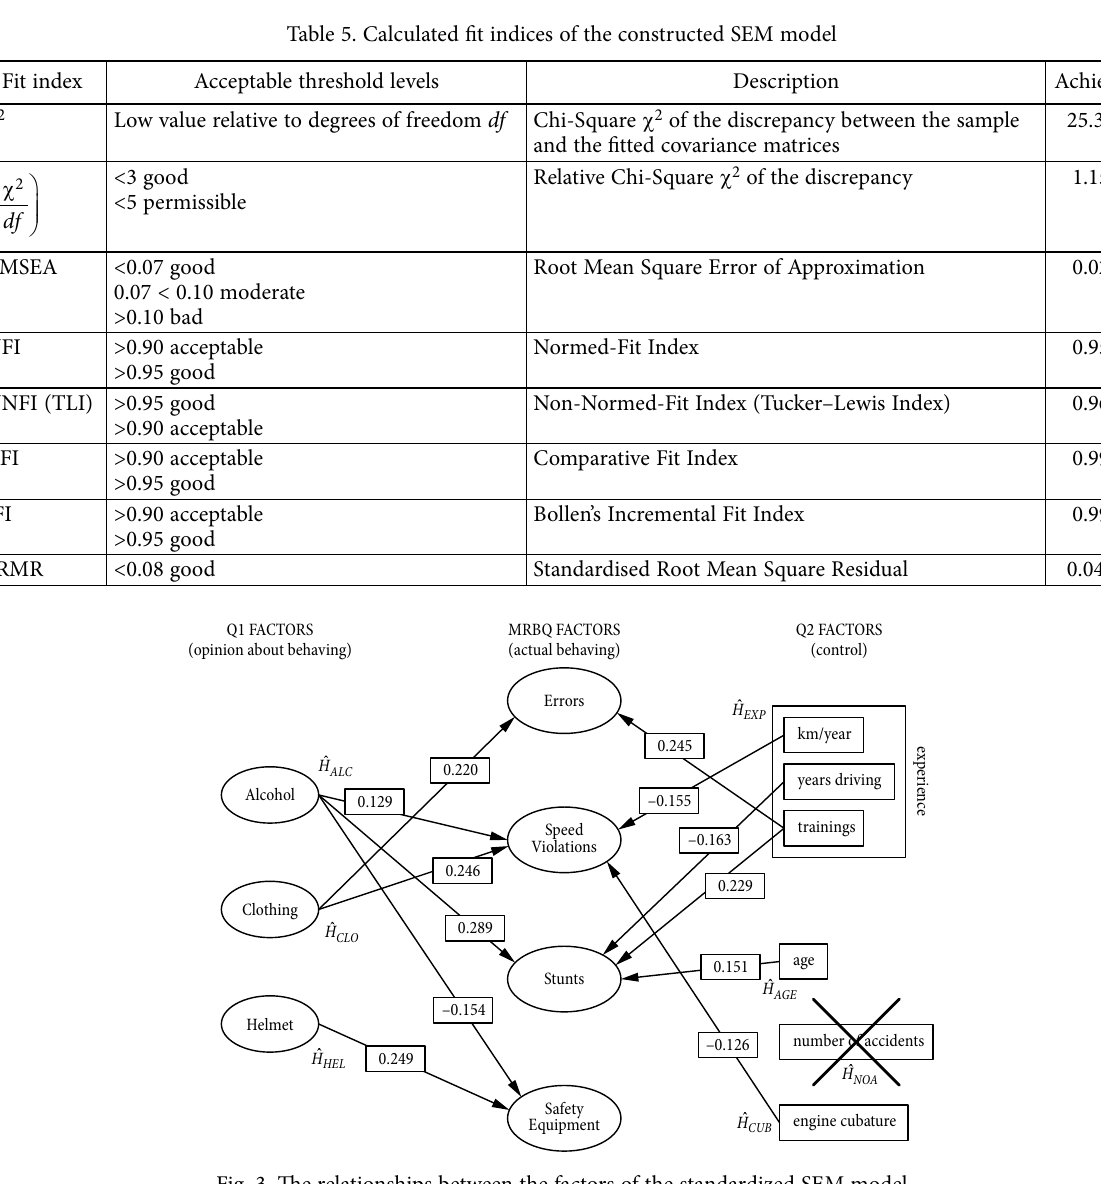
Fig. 3. The relationships between the factors of the standardized SEM